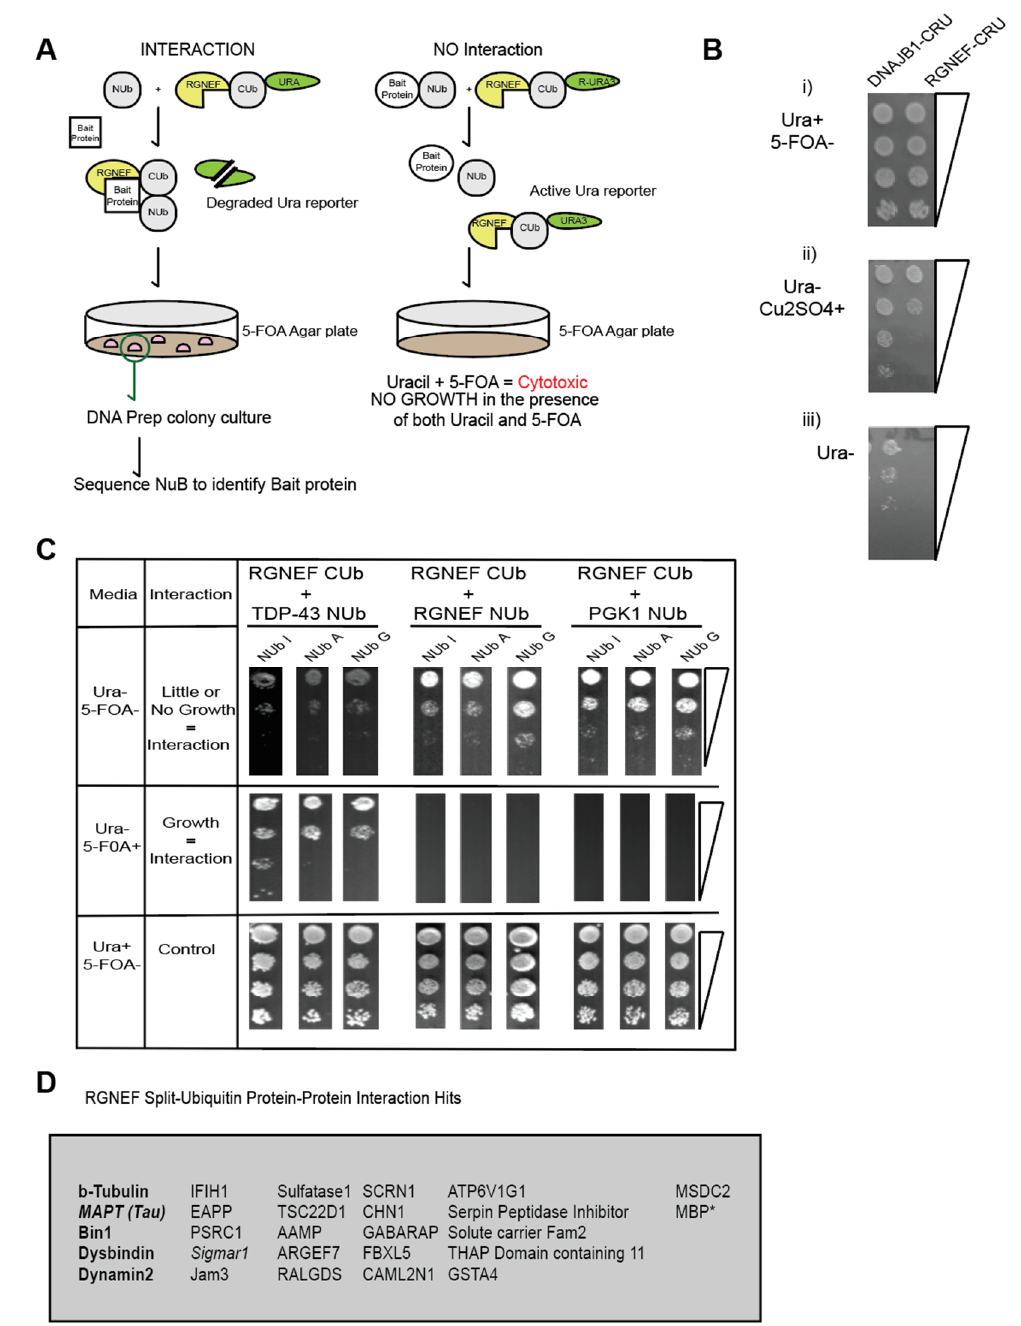
Figure 7. ( A ) RGNEF Split-Ub screen identifies microtubule regulators as interactors with RGNEF. ( B ) Growth assays of yeast cells expressing DNAJB1-CRU (control) and RGNEF-CRU on inducing and non- inducing media, (i) media containing uracil (Ura + ) but not containing 5FOA (5FOA-), (ii) no uracil (Ura-) and copper sulfate (Cu2SO4), and (iii) no uracil (Ura-). ( C ) Split-Ub interactions assays with RGNEF-CRU and TDP-43-NUb (left,) RGNEF-NUb (middle), and PGK1-NUb (right). ( D ) List of all candidate RGNEF interactors identified in a split-Ub screen using RGNEF-CUb-CRU as prey and a human NUbG library as